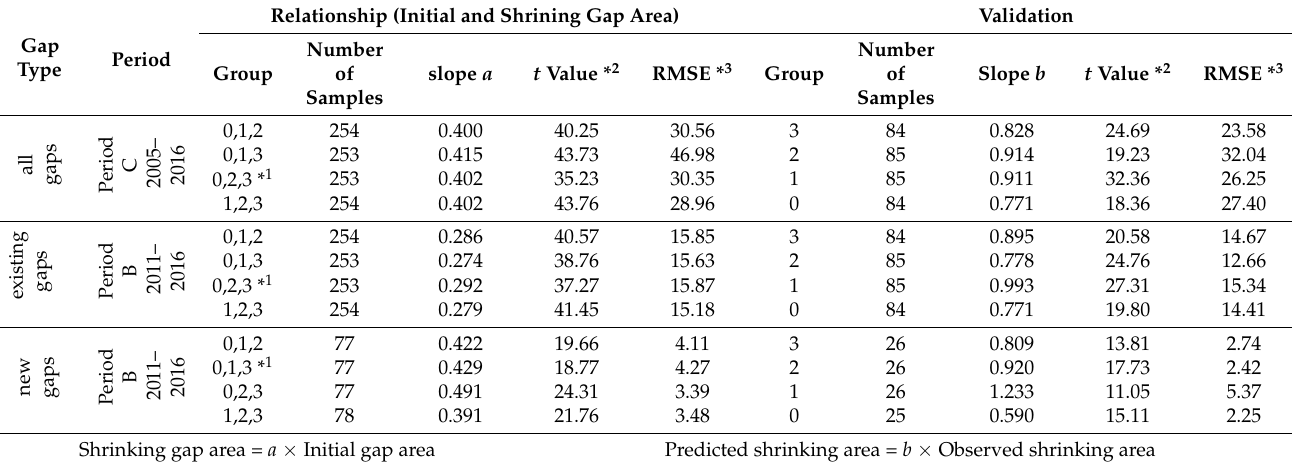
Table 6. Models for prediction of gap shrinkage and their